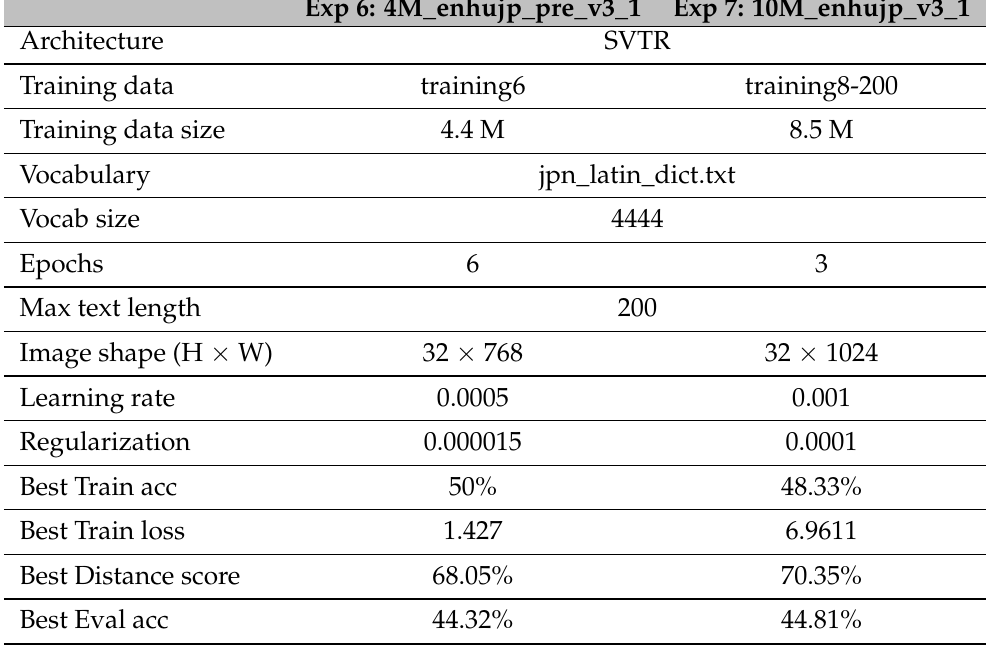
Table 11. Multilanguage experiments: 6 and